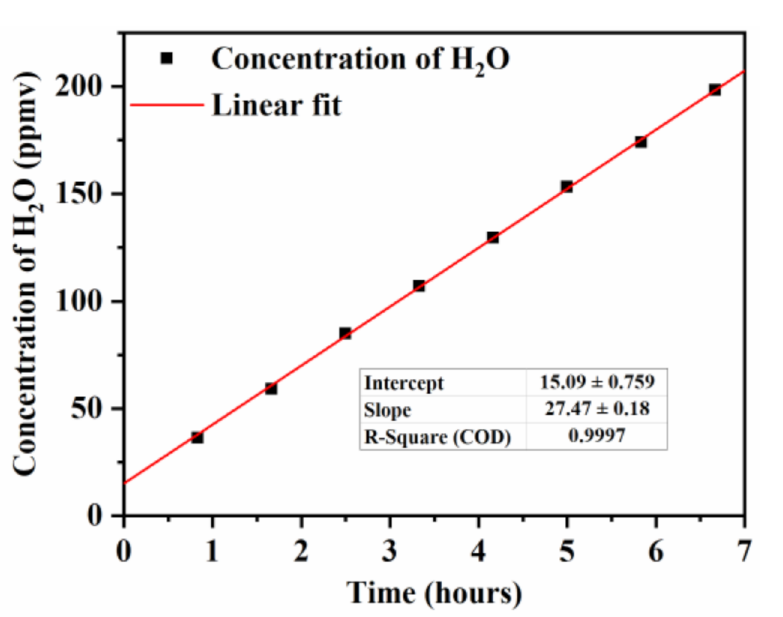
Figure 4. The linear regression of H 2 O